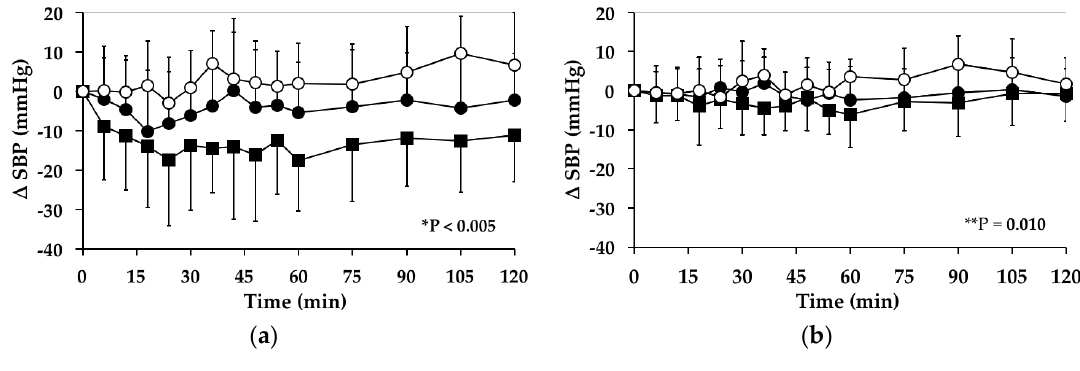
Figure 1. Mean change ( ) in systolic blood pressure (SBP) on “G” ( ), “WW” ( ) and “GW” ( ) days in subjects: ( a ) with postprandial hypotension (PPH); and ( b ) without PPH. Data are mean ± standard deviation (SD) represented by vertical bars. * p < 0.005 and ** p = 0.010 for the area under the curve (AUC) for the change in SBP from baseline between the study days.